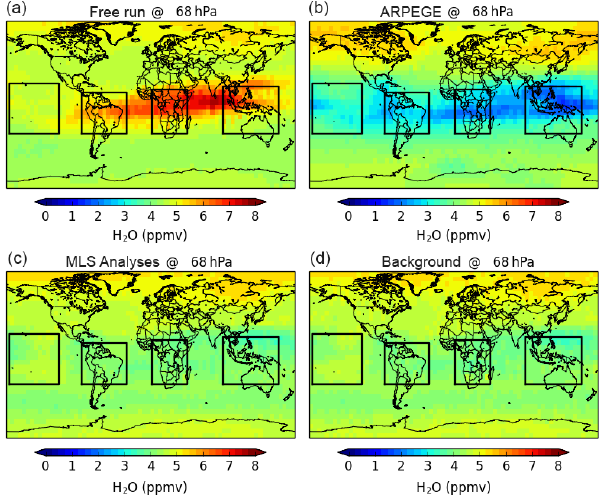
Figure 9. Monthly averaged H 2 O fields at 68hPa in January 2012 in the MLS observation space (in time and space coincidence with MLS observations) from the free run (MOCAGE, a ), ARPEGE (b) , MLS analyses (assimilation, c ) and the background (d)